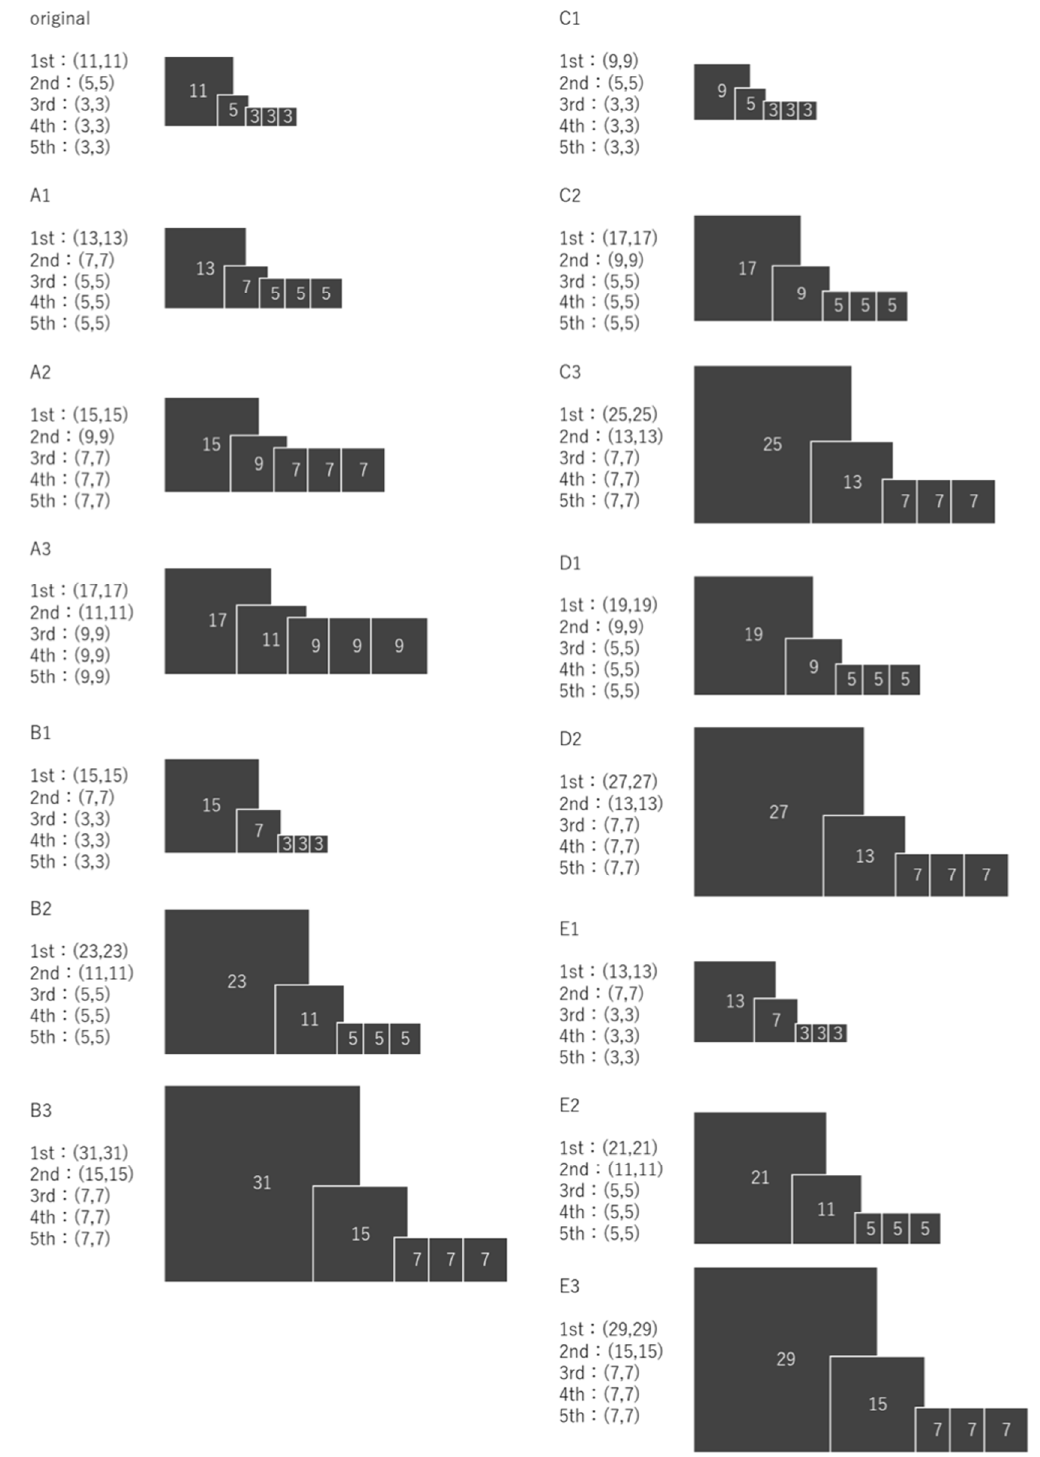
Figure 2. Original and changed values of the filter size of the convolution layer. [( A – E ): the change patterns of group name (groups A to E )].